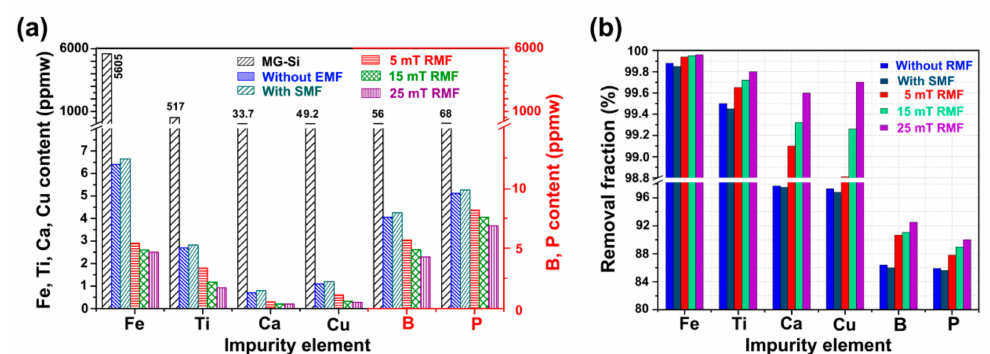
Figure 7. Impurities removal from the primary Si in the solidification process of Al-30Si melts under electromagnetic stirring: ( a ) impurity content, ( b ) removal